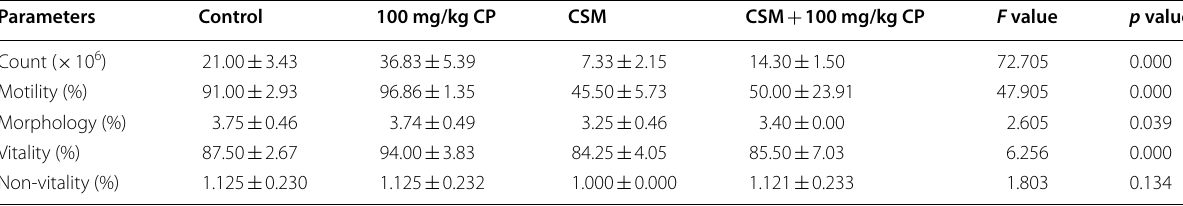
Values are mean standard deviation (mean meal